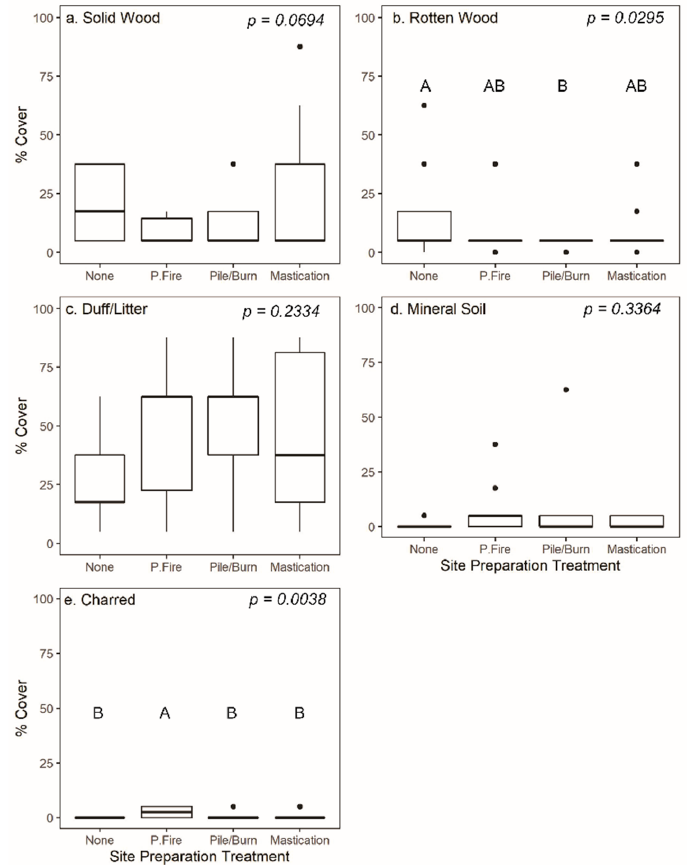
Figure 2. Box plots indicating the variation in forest floor components by site preparation method. Forest floor components include: solid wood which includes sticks and undecomposed wood ( a ), rotten wood includes red rotten or white rotten wood ( b ), litter (needles and leaves) and duff (humus and organic root mass) ( c ), mineral soil at the surface ( d ), and charred or blackened soil ( e ) Litter includes humus (sometimes termed duff). The amount of solid and rotten wood varied, depending on the site preparation, and more mineral soil was exposed in site preparation methods that included burning (prescribed fire and pile and burn). Letters indicate significant differences among site preparation methods.